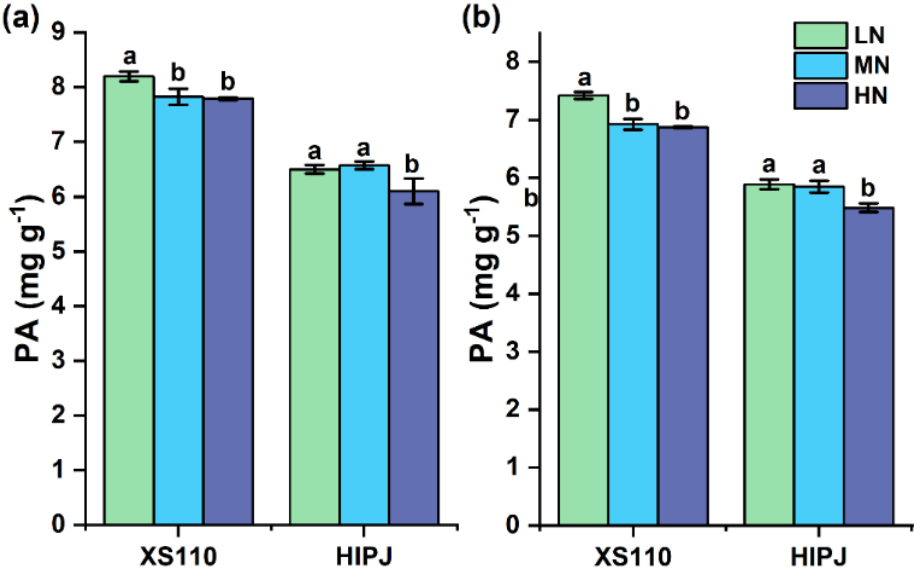
Figure 2. Effect of N levels on grain phytic acid (PA) concentration on rice grain under hydroponic culture; ( a ) 2015; ( b ) 2016. LN: low nitrogen level; MN: medium nitrogen level; HN: high nitrogen level. Bars indicate the mean ± SE. Different letters for every three N levels (LN, MH, HN) denoted significant differences according to one-way ANOVA analysis followed by Tukey’s multiple comparison test. Table 4. Effect of N levels on grain P components (phytic acid, inorganic phosphorus, total phos- phorus, and PA-P/TP) in the detached panicle culture system.